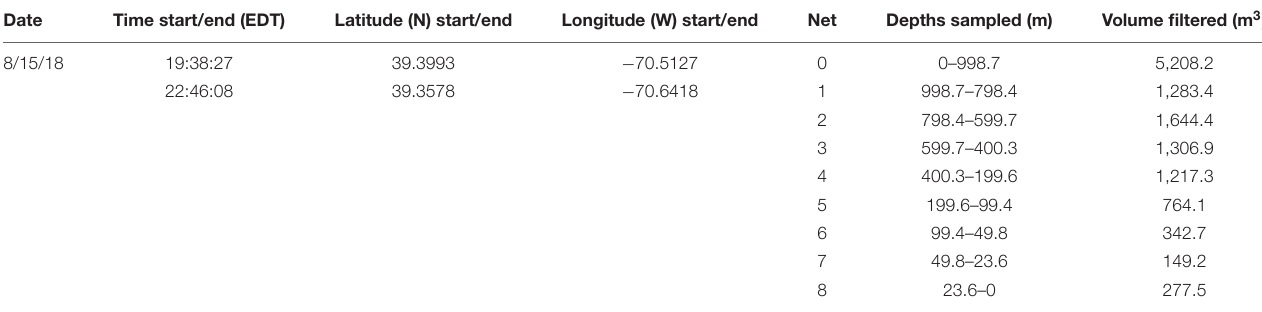
TABLE 2 | MOCNESS tow